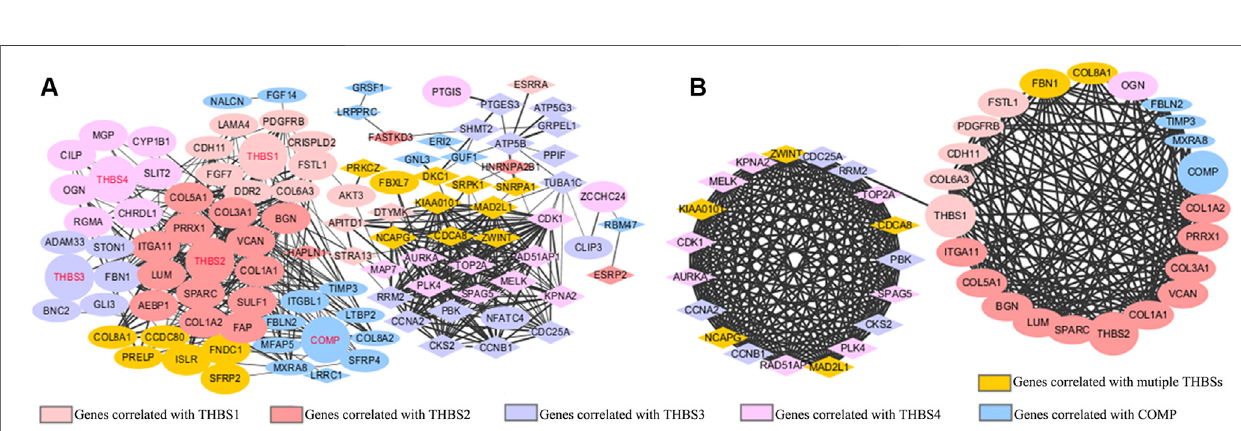
Frontiers in Molecular Biosciences |